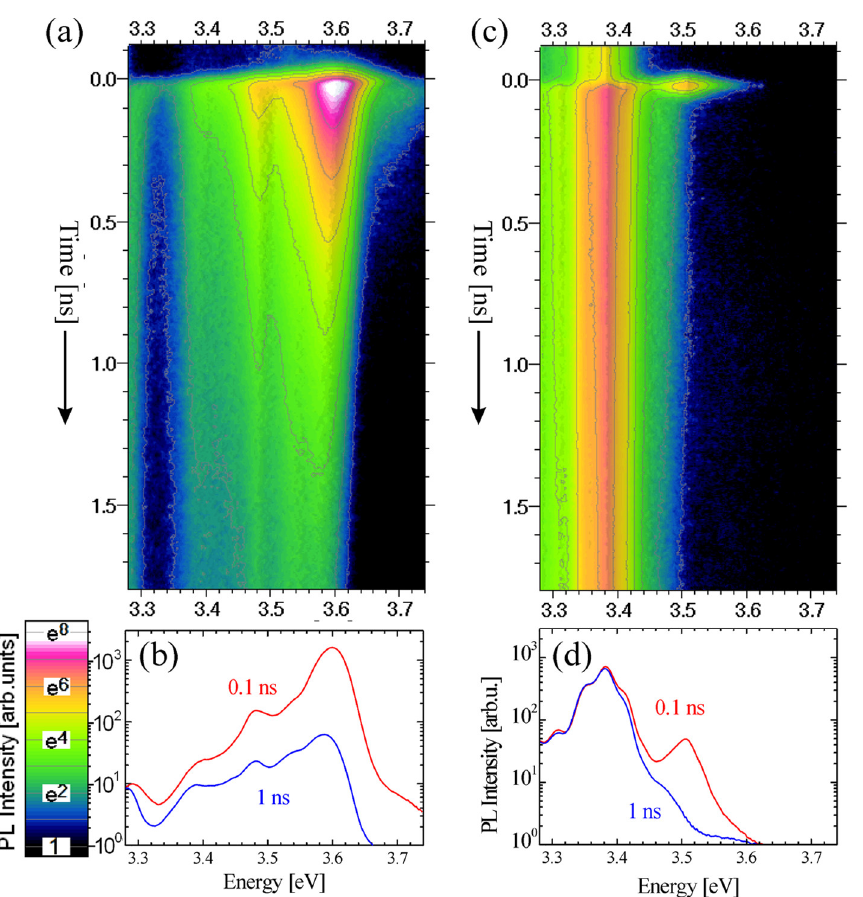
Figure 4. Time-resolved low-temperature PL spectra of ( a , b ) non-polar and ( c , d ) polar GaN/Al 0.26 Ga 0.74 N (3 nm/22.5 nm) MQW structures: ( a , c ) contour plots of PL intensity vs. time and energy; and ( b , d ) PL spectra at short (0.1 ns) and long (1ns) times after the laser pulse. The relatively weak lines visible around 3.5 eV originate from the GaN cap.